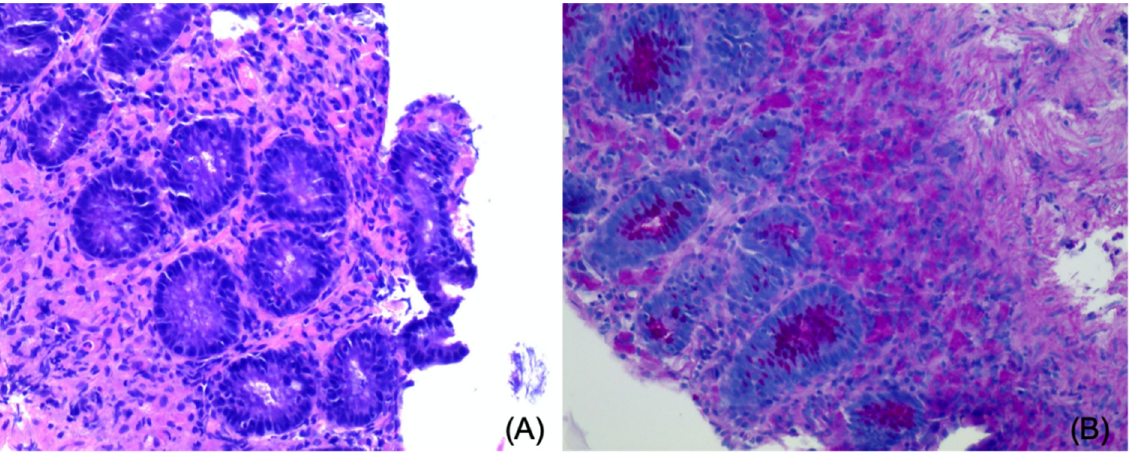
Figure 4. Histology of the colonic wall. ( A ) Moderate amount of edema and fibrosis of the lamina propria (Hematoxylin and Eosin); ( B ) presence of a dense infiltrate of strong PAS-positive macrophages (PAS).